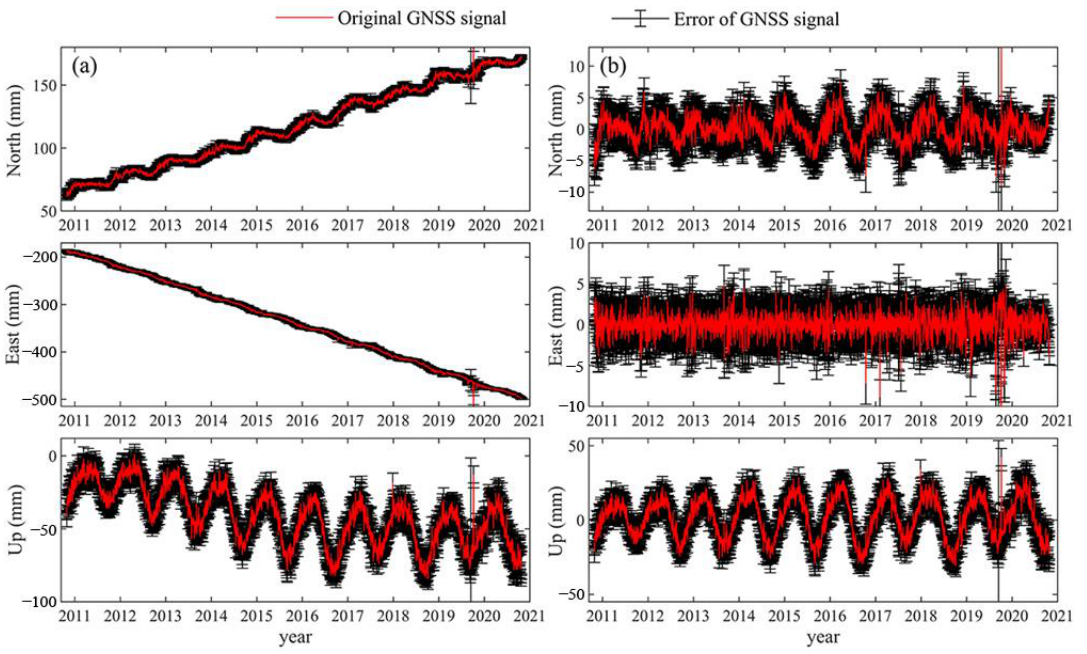
Figure 2. ( a ) Raw coordinate time series of P242 station, and ( b ) the corresponding residual time series.